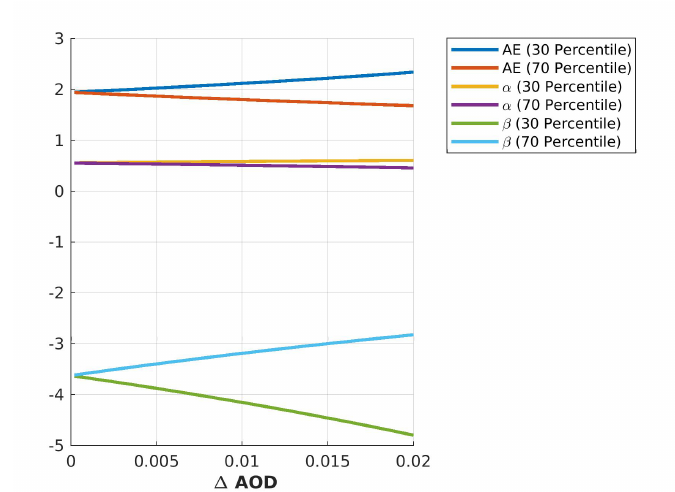
Figure 3. 30th and 70th percentile for traditional and modified Ångström parameters AE , α , and β depending on the noise level ∆ AOD